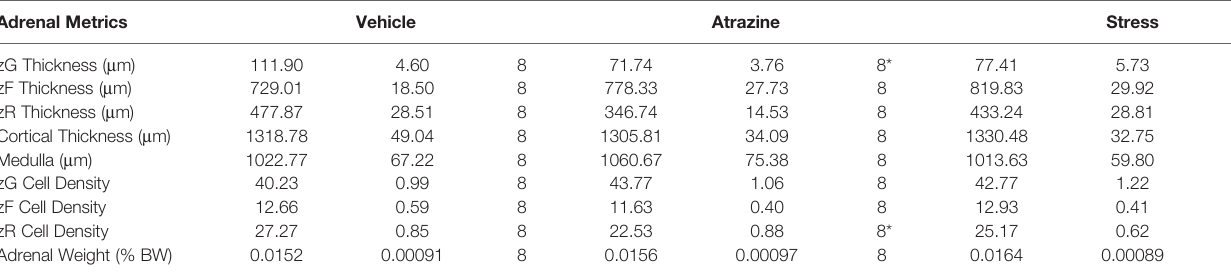
TABLE 2 | Effects of atrazine or stress treatment on adrenal morphology. Adrenal